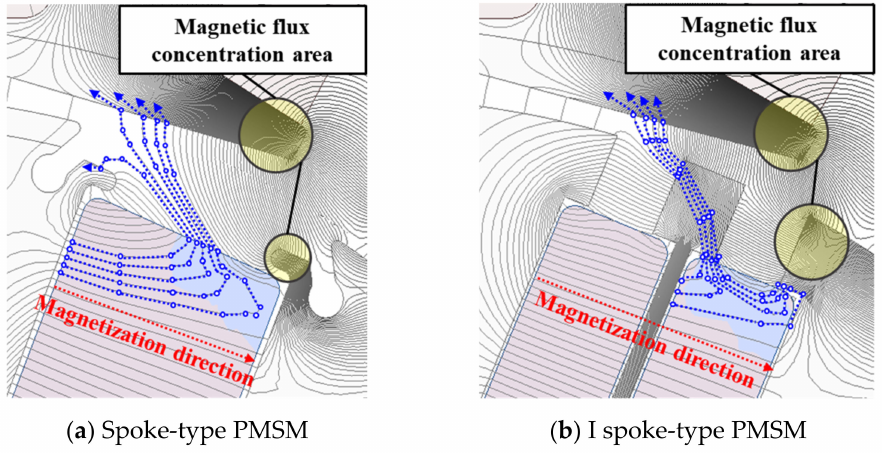
Figure 15. Comparison of flux-line according to the rotor